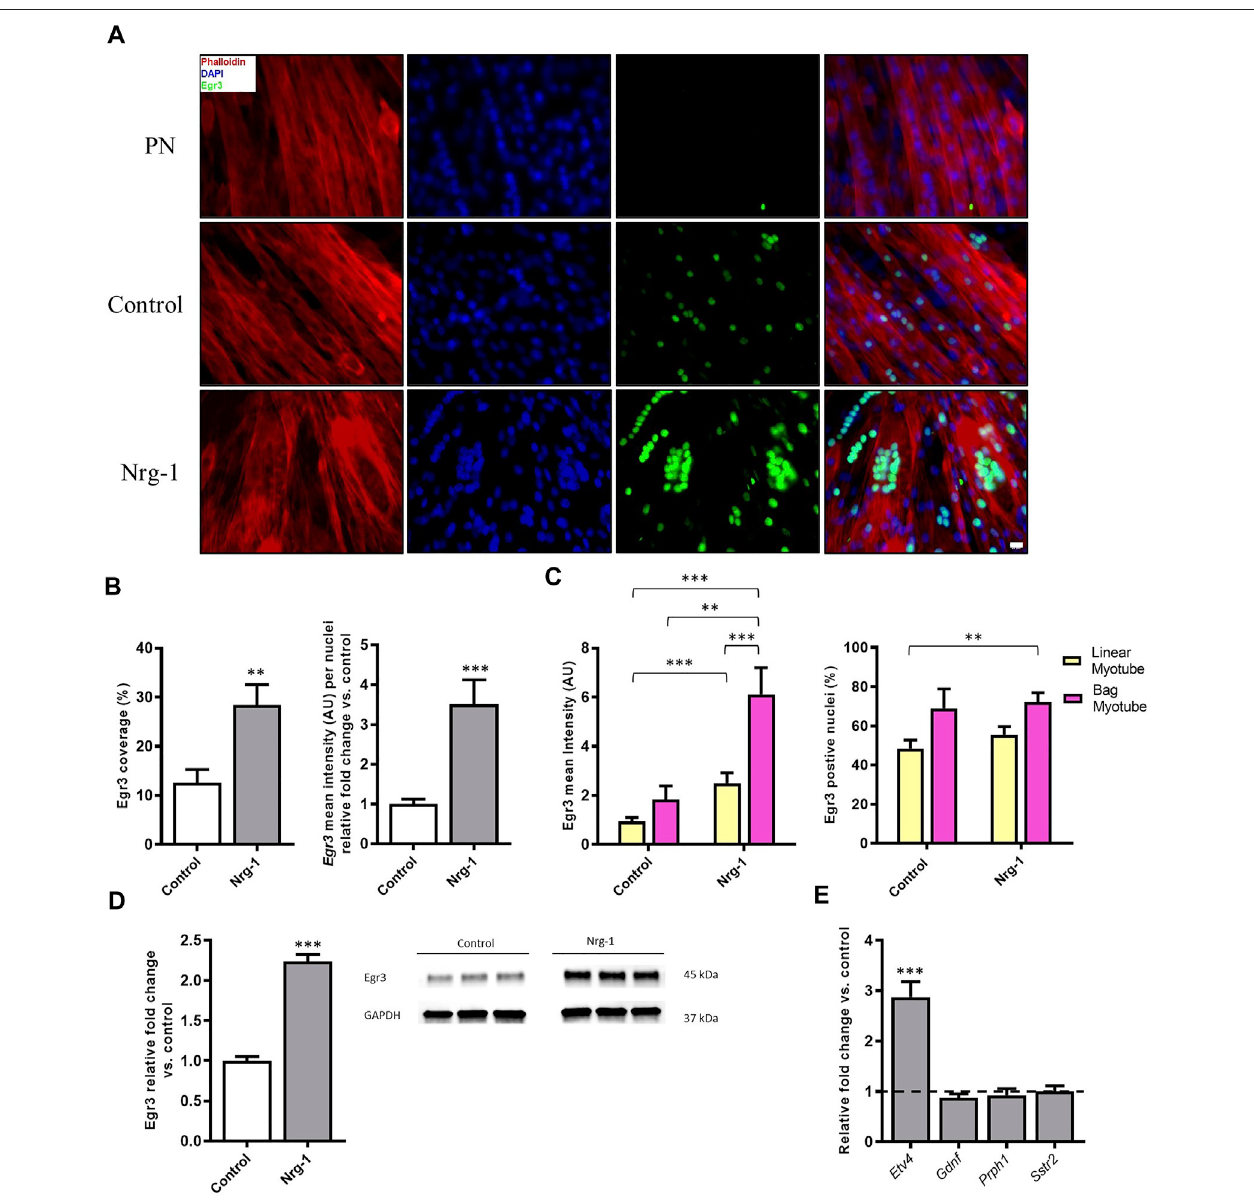
FIGURE 6 | Increased expression of Egr3 protein in Nrg-1 treated C2C12 myotubes and intrafusal bag myotubes. (A) representative fl uorescent micrographs following Nrg-1 treatment, (scale bar, 20 µm) Phalloidin (red), DAPI (blue) and Egr3 (green). (B) Percentage of Image covered by positive Egr3 expression (above threshold)and Egr3intensity foldchangepernucleirelativetocontrol. (C) Two-way ANOVAanalysisoftreatment and myotubetype, Left- MyotubeEgr3intensityRight- Egr3 positive nuclei %. Control Linear -52 myotubes, Control-Bag - 9 myotubes, Nrg-1-Linear - 47 myotubes, Nrg-1-Bag – 26 myotubes. (D) Western blot representative image and relative fold change for Egr3, each lane is a biological repeat ( n (cid:1) 3, from three blots). (E) Gene expression of additional putative intrafusal speci fi c proteins relative to control. Mean ± SEM, n (cid:1) 3, ** p < 0.01, *** p < 0.001.